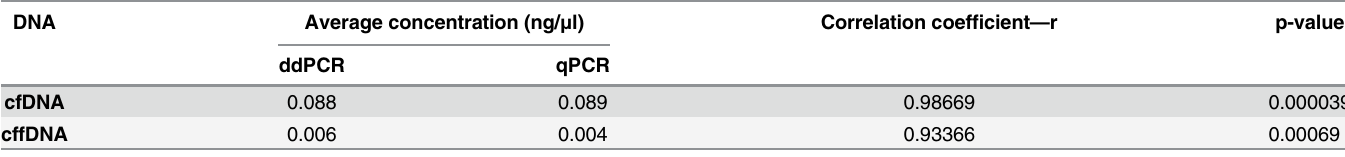
Table 2. Average concentrations of cfDNA (quantified as GAPDH content in all 35 samples analysed) and cffDNA (measured as RHD amplification in 25 samples with fetal RhD-positive status) in plasma samples of RhD-negative pregnant women determined by qPCR and ddPCR. DNA